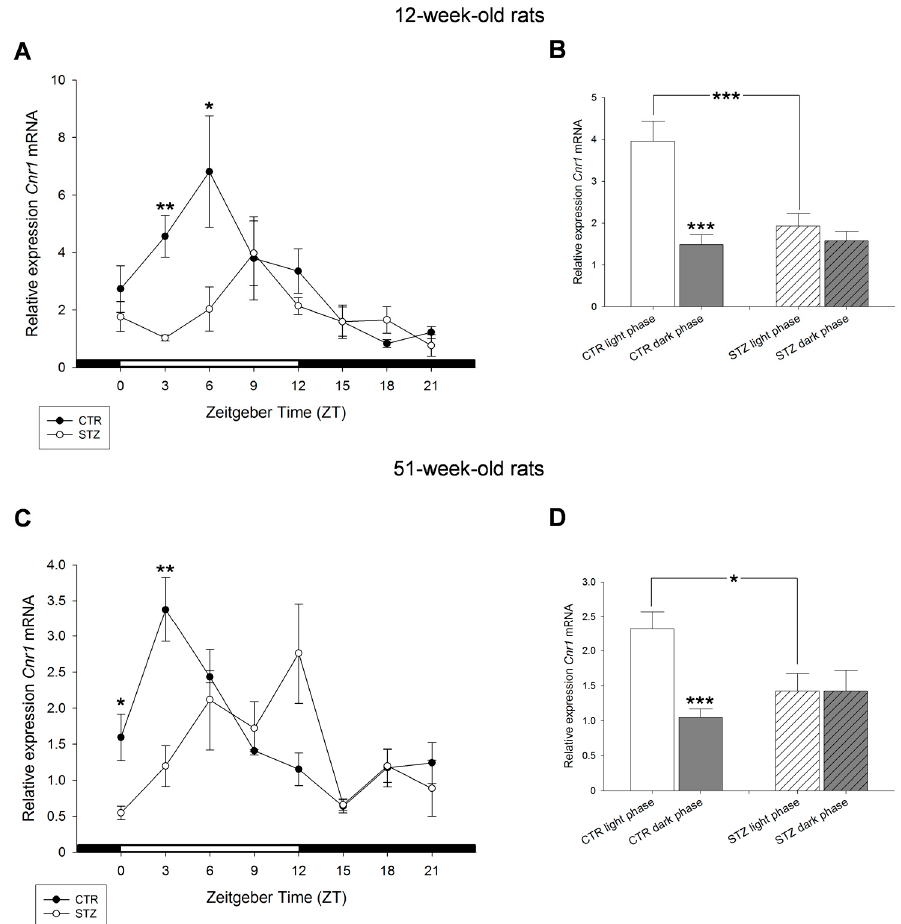
Figure 6. Effects of streptozotocin on the diurnal expression of cannabinoid receptor Cnr1 mRNA in the liver of: 12-week-old rats ( A , B ); and 51-week-old rats ( C , D ). ( A , C ) Streptozotocin treated Wistar rats (STZ) are shown compared to control Wistar rats (CTR). ( B , D ) Values of light phase as well as those of dark phase are summarized for Cnr1 mRNA of control Wistar rats (CTR) and streptozotocin treated rats (STZ) showing decreased expression of Cnr1 mRNA in STZ rats during light period compared to control. Values are means (±S.E.M.), as analyzed by Mann–Whitney test. * p < 0.05, ** p < 0.01, *** p < 0.001.